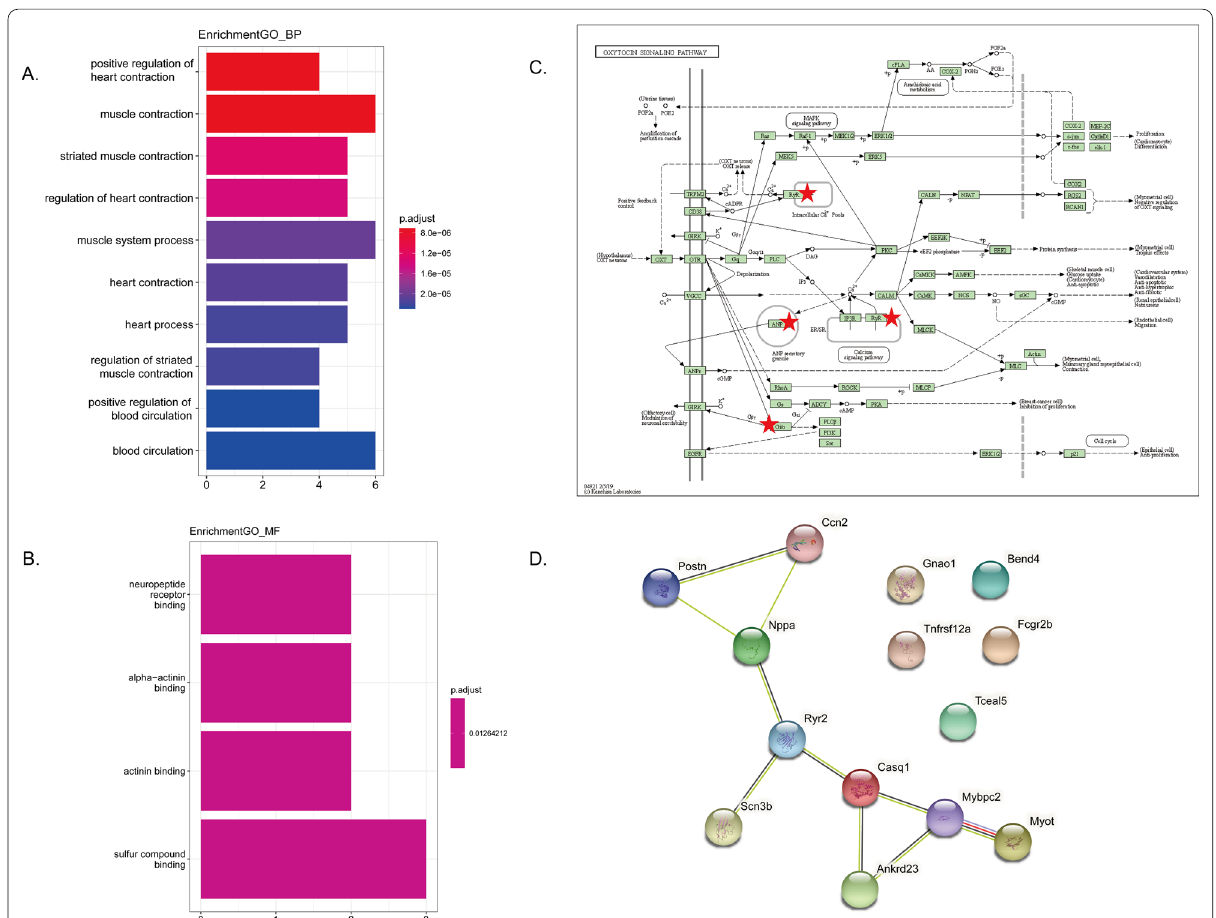
Fig. 4 Enrichment analysis and PPI analysis. A Biological process in the functional enrichment analysis for the 14core genes. B Molecular function in the functional enrichment analysis for the 14 core genes. C Oxytocin signaling pathway revealed by KEGG enrichment analysis for the 14 core genes. The star represents the core genes in oxytocin signaling pathway. D PPI analysis using STRING